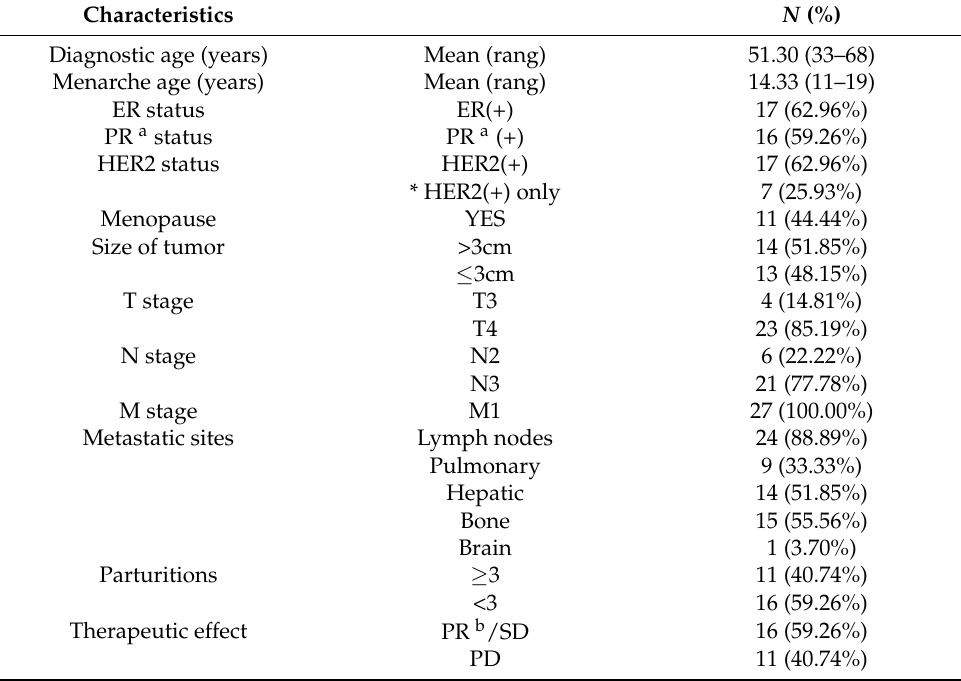
Table 1. Clinical characteristics of MBC